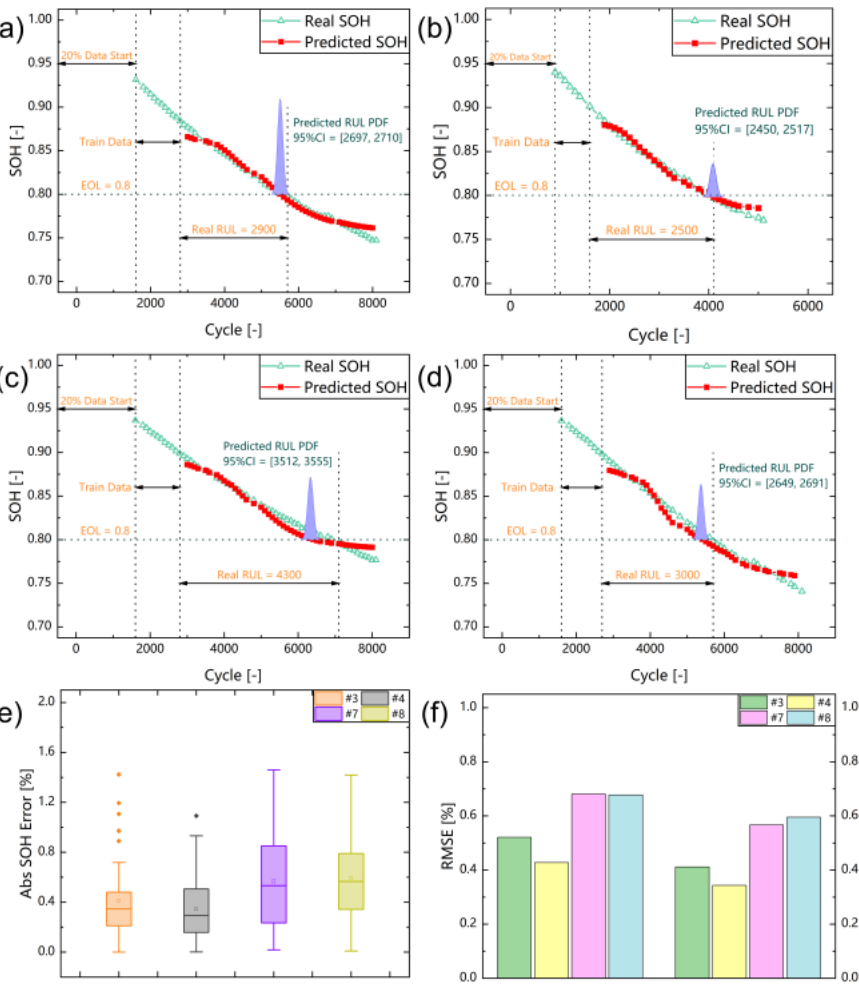
Figure 11. SOH and RUL estimation results of the proposed model using singular value as input features. ( a ) Estimation results for battery #3. ( b ) Estimation results for battery #4. ( c ) Estimation results for battery #7. ( d ) Estimation results for battery #8. ( e ) Box-plot analysis for four batteries. ( f ) RMSE and MAE analysis for four batteries.